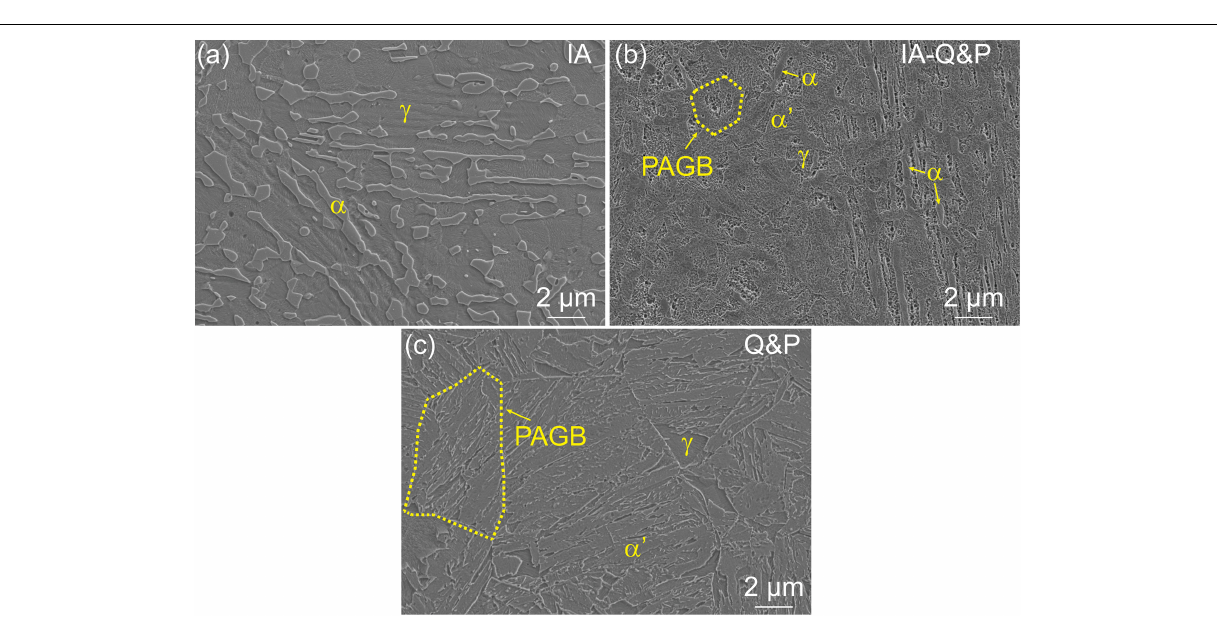
FIGURE 2 | SEM images of the (a) IA steel (680 ◦ C/240 min), (b) IA-Q&P steel (800 ◦ C –350 ◦ C), and (c) Q&P steel (900 ◦ C –350 ◦ C), respectively. a, ferrite; g, austenite; a’, martensite; PAGB, prior austenite grain boundary. The dent part is the austenite. The embossment part is ferrite phase or martensite. The surface of the martensite phase is rougher than that of the ferrite